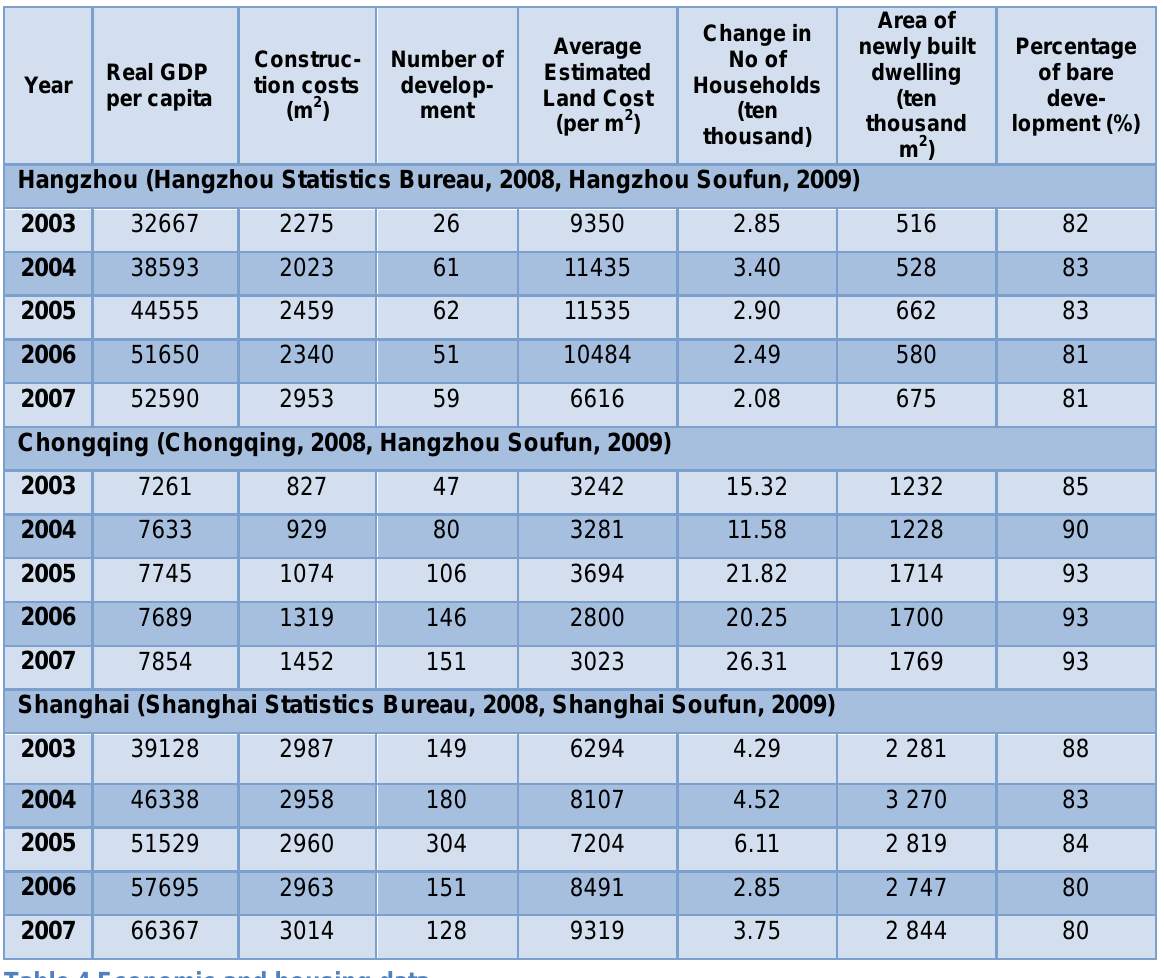
Table 4 Economic and housing